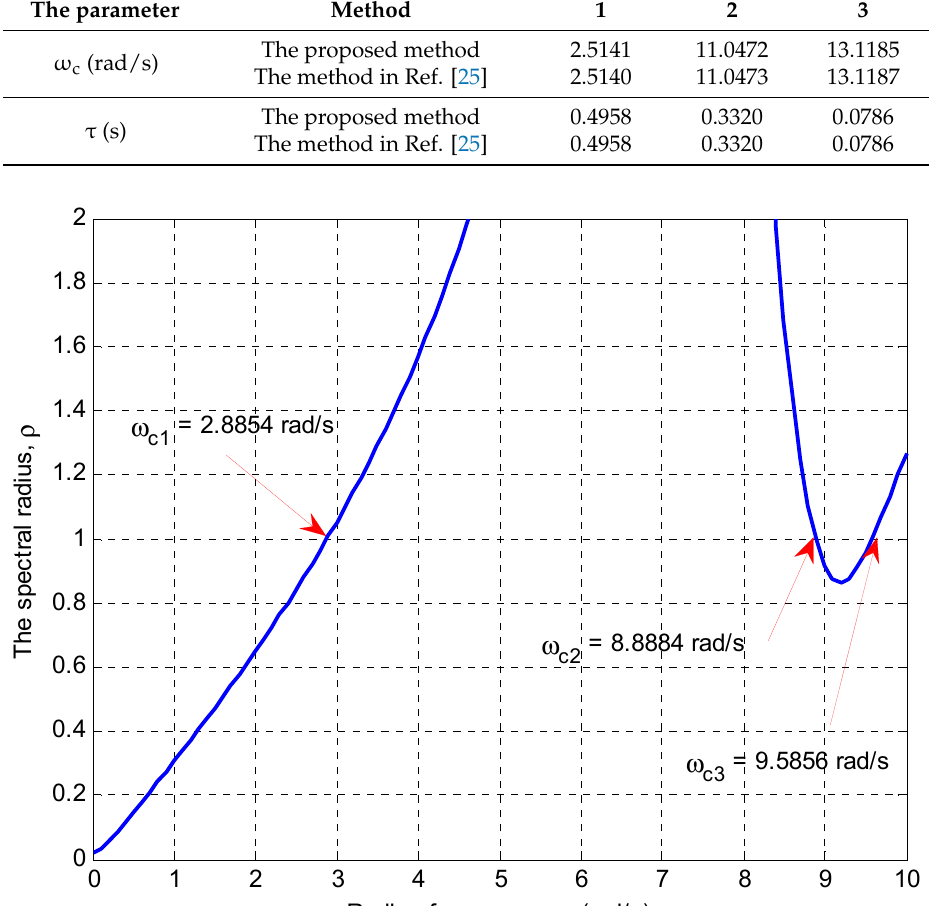
Figure 8. The terminal voltage with different time delays.